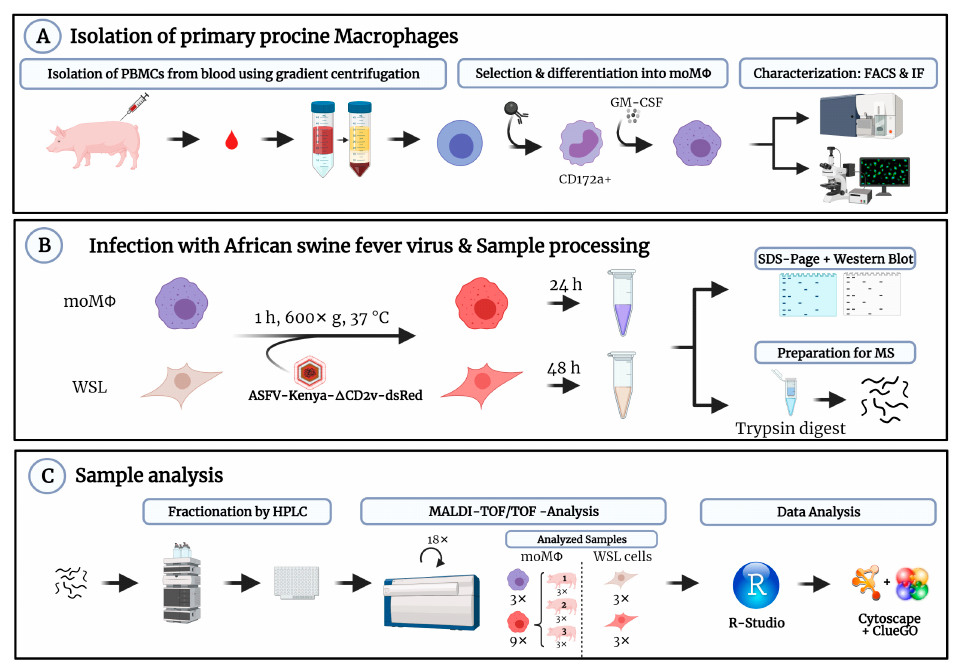
Figure 1 . Workflow for generation, processing and analysis of samples for proteome analysis. ( A ) Isolation, selection and differentiation one day after isolation and quality control of primary moM Φ , ( B ) ASFV infection, sample generation and processing for MS analysis, ( C ) analysis of peptides by HPLC ‐ MALDI ‐ TOF/TOF MS workflow and data processing.